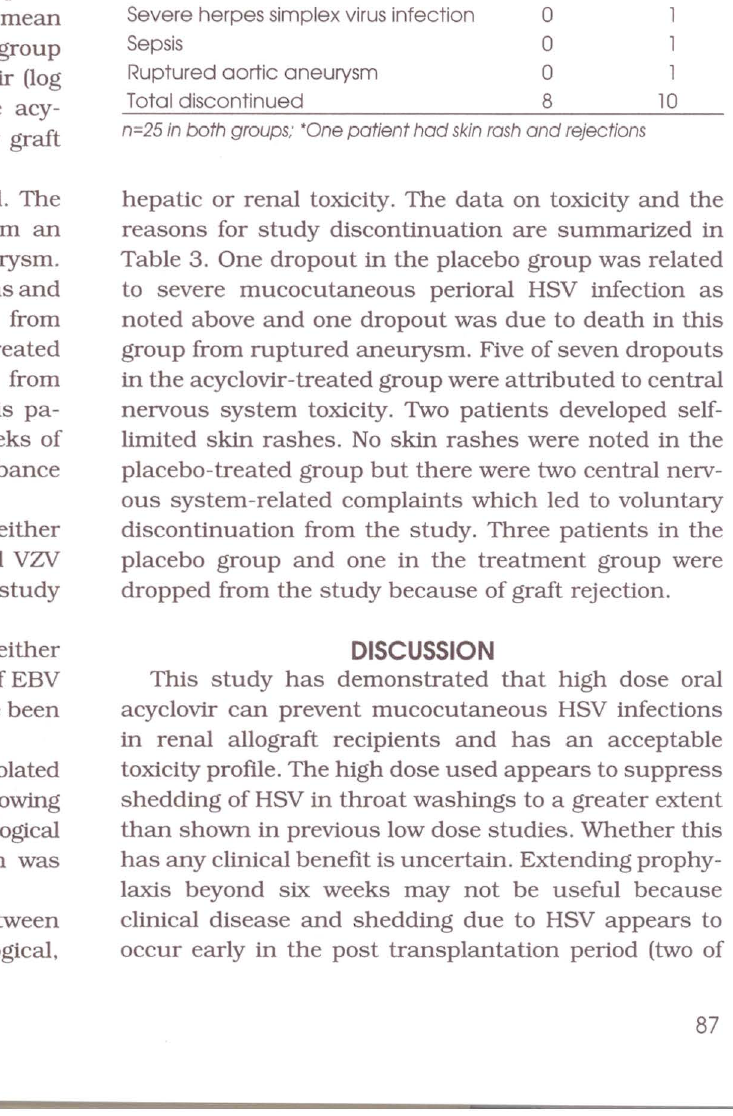
Reasons for patient withdrawal from study Symptoms/signs